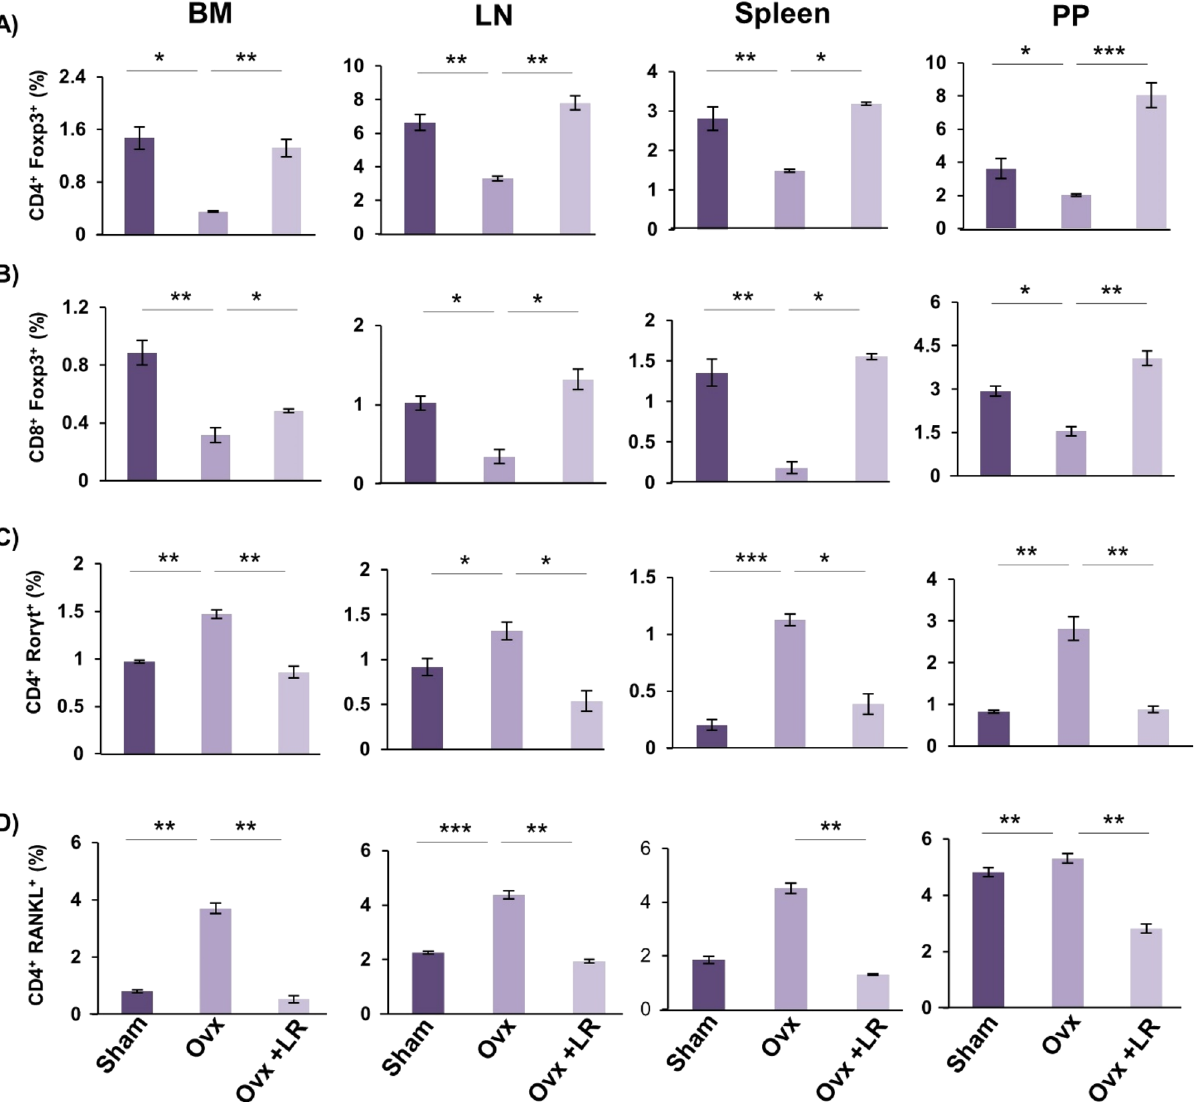
CD4 + Foxp3 + Tregs. ( B ) CD8 + Foxp3 + Tregs. ( C ) CD4 + Roryt + Th17 cells. ( D ) CD4 + RANKL + T cells. Data